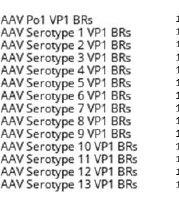
Figure 1. Alignment of AAV VP1 N-terminal domain Basic Regions. Alignment of human/primate AAV VP1 N-terminal domain encompassing basic regions 1–3 compared with AAV Po1 VP1 N-terminal domain. Sequences obtained from NCBI database: AAV Po1 (ACN42940.1), AAV 1 (NP_049542.1), AAV 2 (YP_680426.1), AAV 3 (NP_043941.1), AAV 4 (NP_044927.1), AAV 5 (YP_068409.1), AAV 6 (AAB95450.1), AAV 7 (YP_077178.1), AAV 8 (YP_077180.1), AAV 9 (AAS99264.1), AAV 10 (AAS99263), AAV 11 (AAT46339.1), AAV 12 (ABI16639.1), AAV 13 (ABZ10812.1). Residues highlighted in red show 100% sequence identity. Residues highlighted in yellow show a possible alternative basic region for AAV5 and AAV Po1. Geneious Prime (version 2020.2.3) was used to generate alignment.